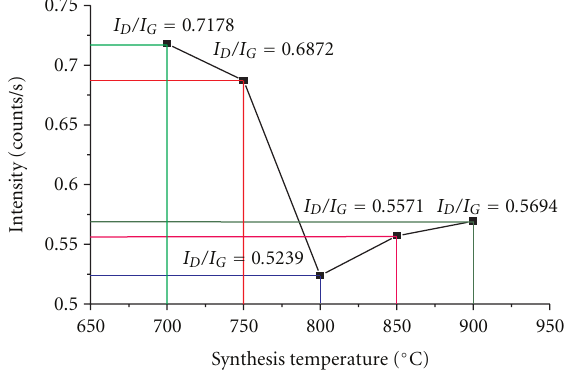
Figure 5: I D /I G ratio of aligned CNT at di ff erent synthesis